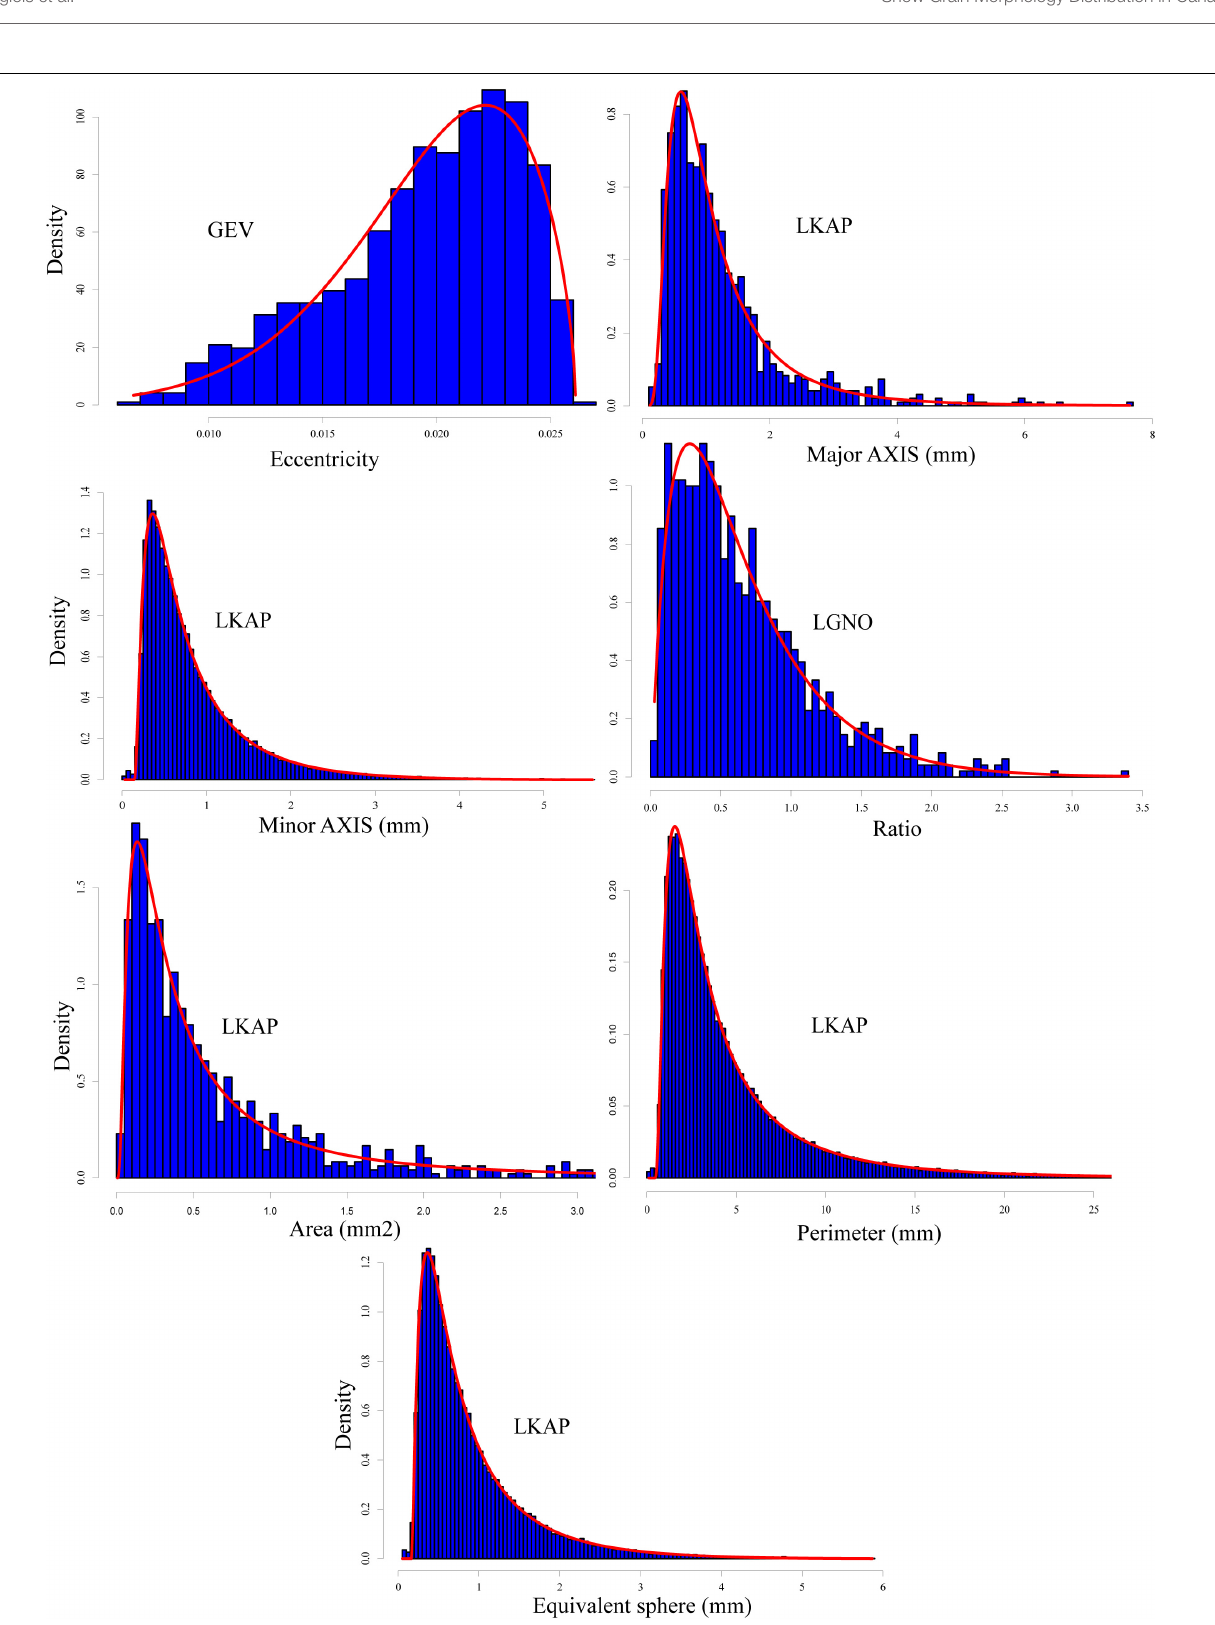
Frontiers in Earth Science |